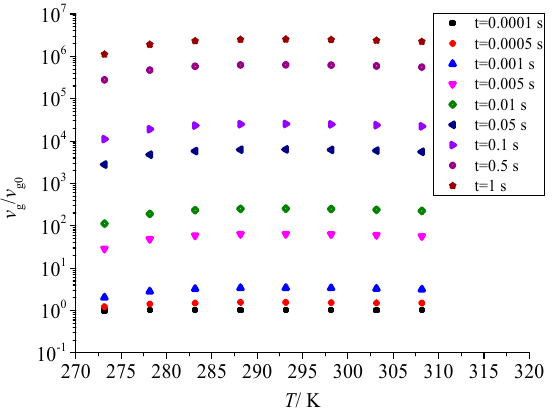
Figure 15. Effect of temperature on dimensionless geometric volume.